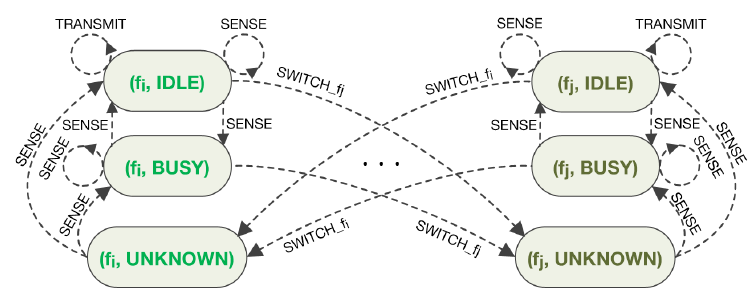
Figure 1. JSS problem formulation presented as